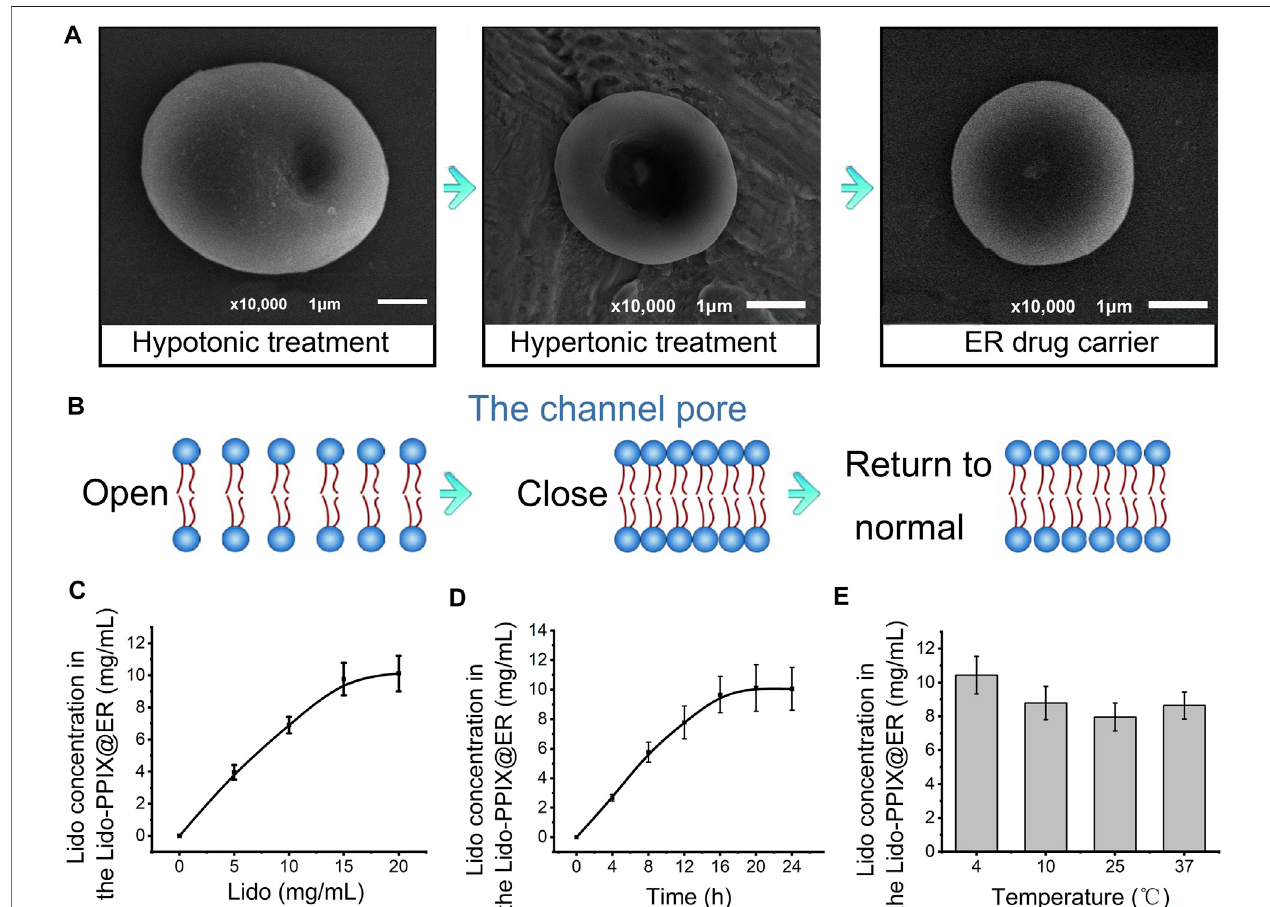
FIGURE 1 | Construction of Lido-PPIX@ER. (A) SEM images of Lido-PPIX@ER during hypotonic, hypertonic or PBS treatment. (B) Schematic diagram of phospholipid bilayer changes during hypotonic, hypertonic or PBS treatment. (C) Relationship between the initial Lido concentration and loading content. (D) Effect of dialysis duration on the Lido loading content. (E) Relationship between the temperature and loading